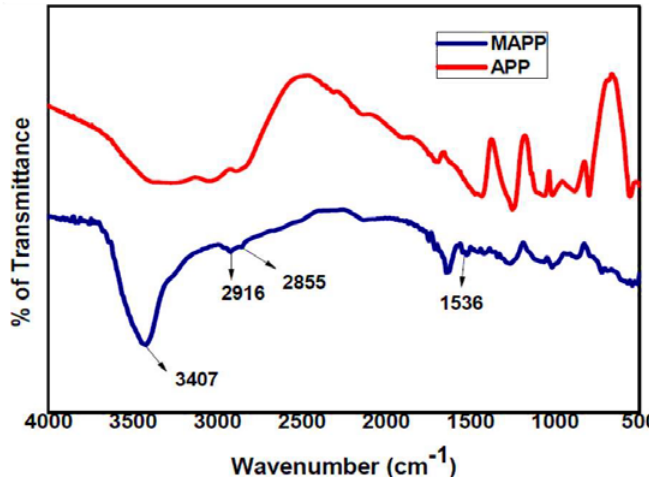
Figure 1. FTIR spectra of APP and MAPP.